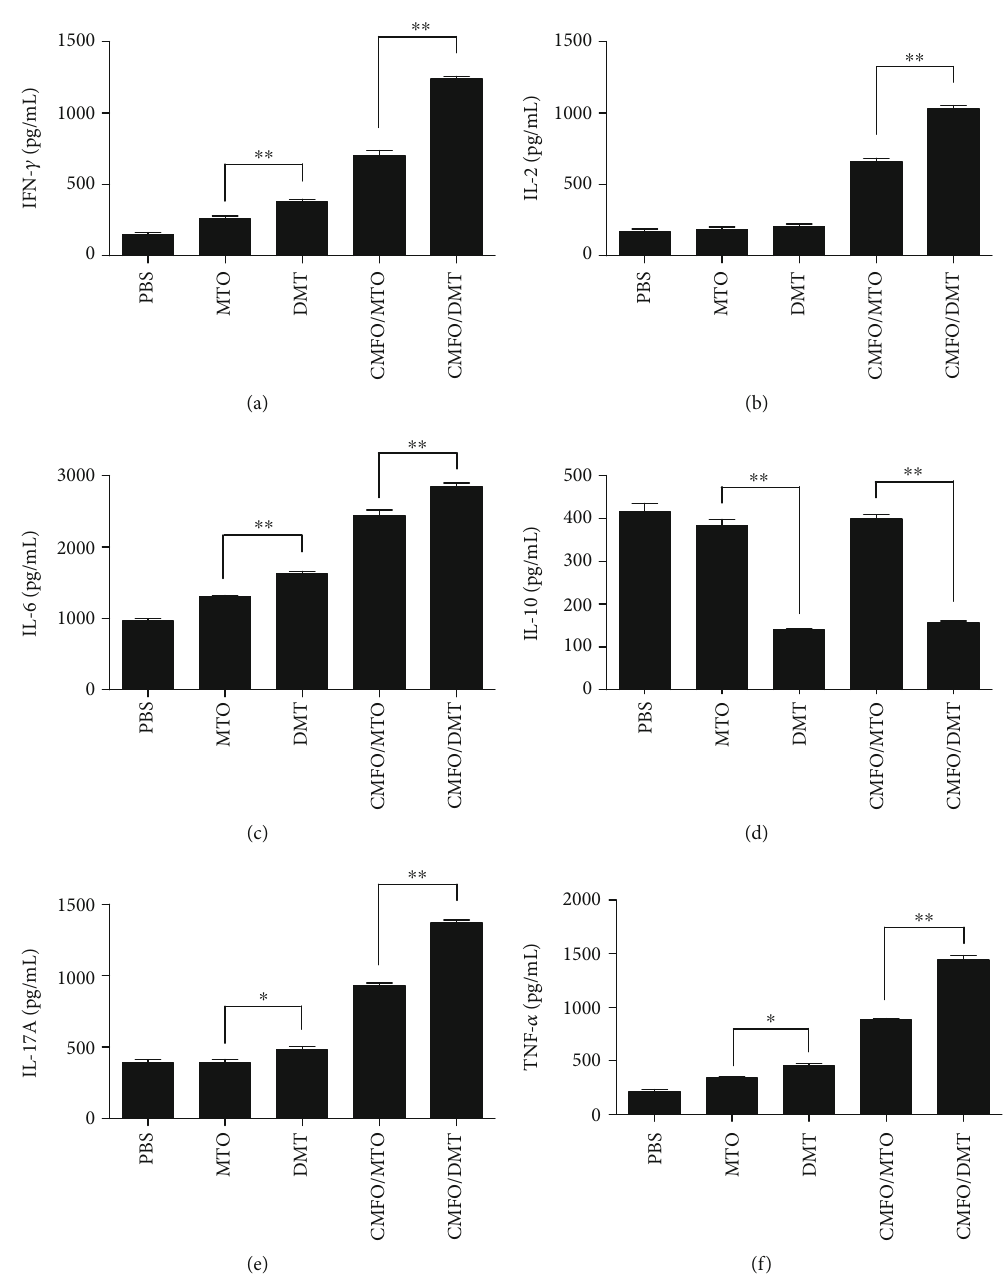
Figure 2: The levels of CMFO-speci fi c cytokines secreted by splenocytes ( n = 6 ). 10 weeks after immunization, 5 × 10 6 splenocytes from di ff erent immunized mice were restimulated with 10 μ g/mL CMFO for 72 h. The supernatants were collected from each well, and the levels of CMFO-speci fi c Th1/Th2/Th17 cytokines containing IFN- γ (a), TNF- α (b), IL-2 (c), IL-10 (d), IL-6 (e), and IL-17A (f) were detected by a CBA kit. The results were expressed as the mean ± SEM (pg/mL). ∗ p < 0 : 05 and ∗∗ p < 0 : 001 . The concentration of IL-4 in each group was less than 1pg/mL, and data were not